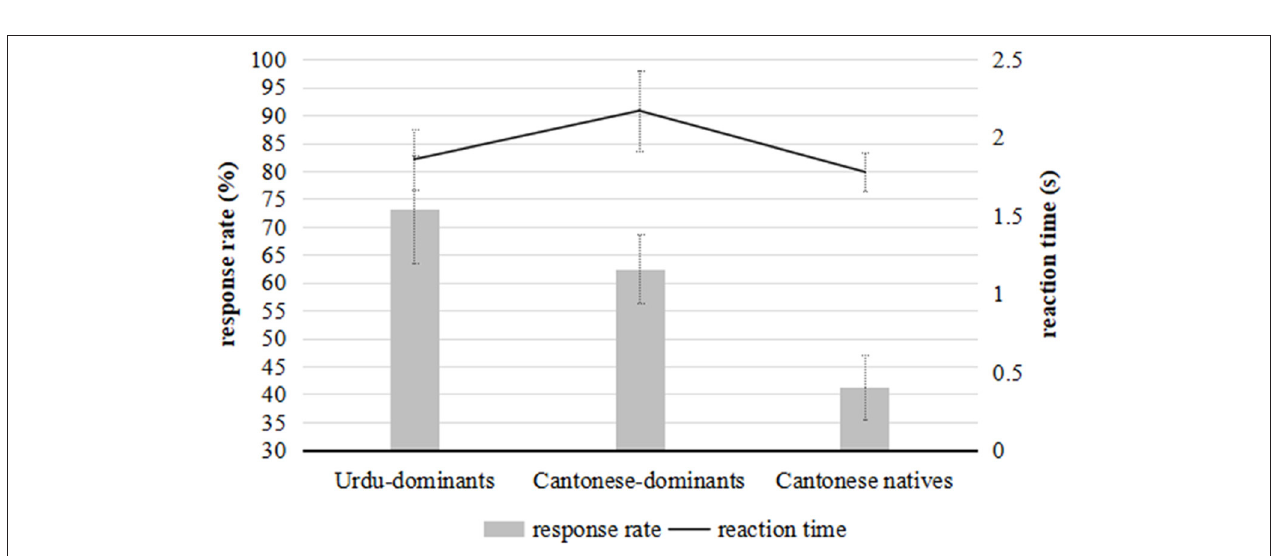
FIGURE 3 | The mean accuracy/response rates (gray bars) and reaction time (dark line) for the bilinguals and Cantonese native speakers in the task of segment-and-tone. The minor y-axis shows the response time and the main y-axis illustrates the response rate. The error bars show 1/2 of SD .